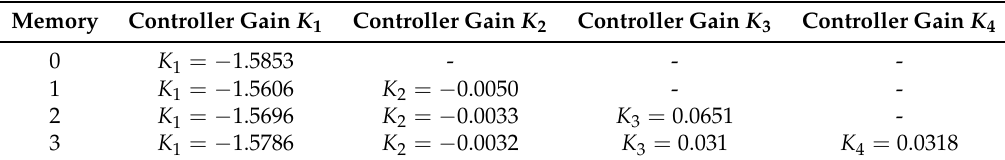
Table 1. The controller gain matrices for each memory number.